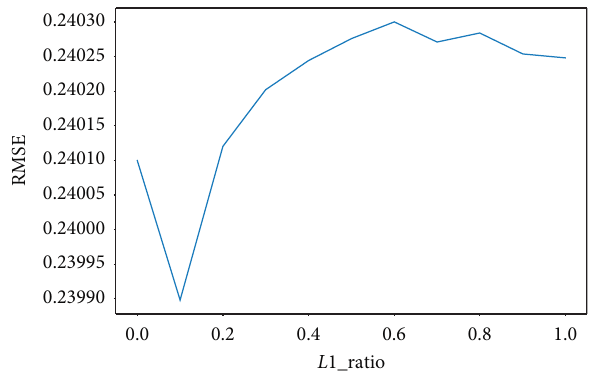
Figure 6: Variation of RMSE with L